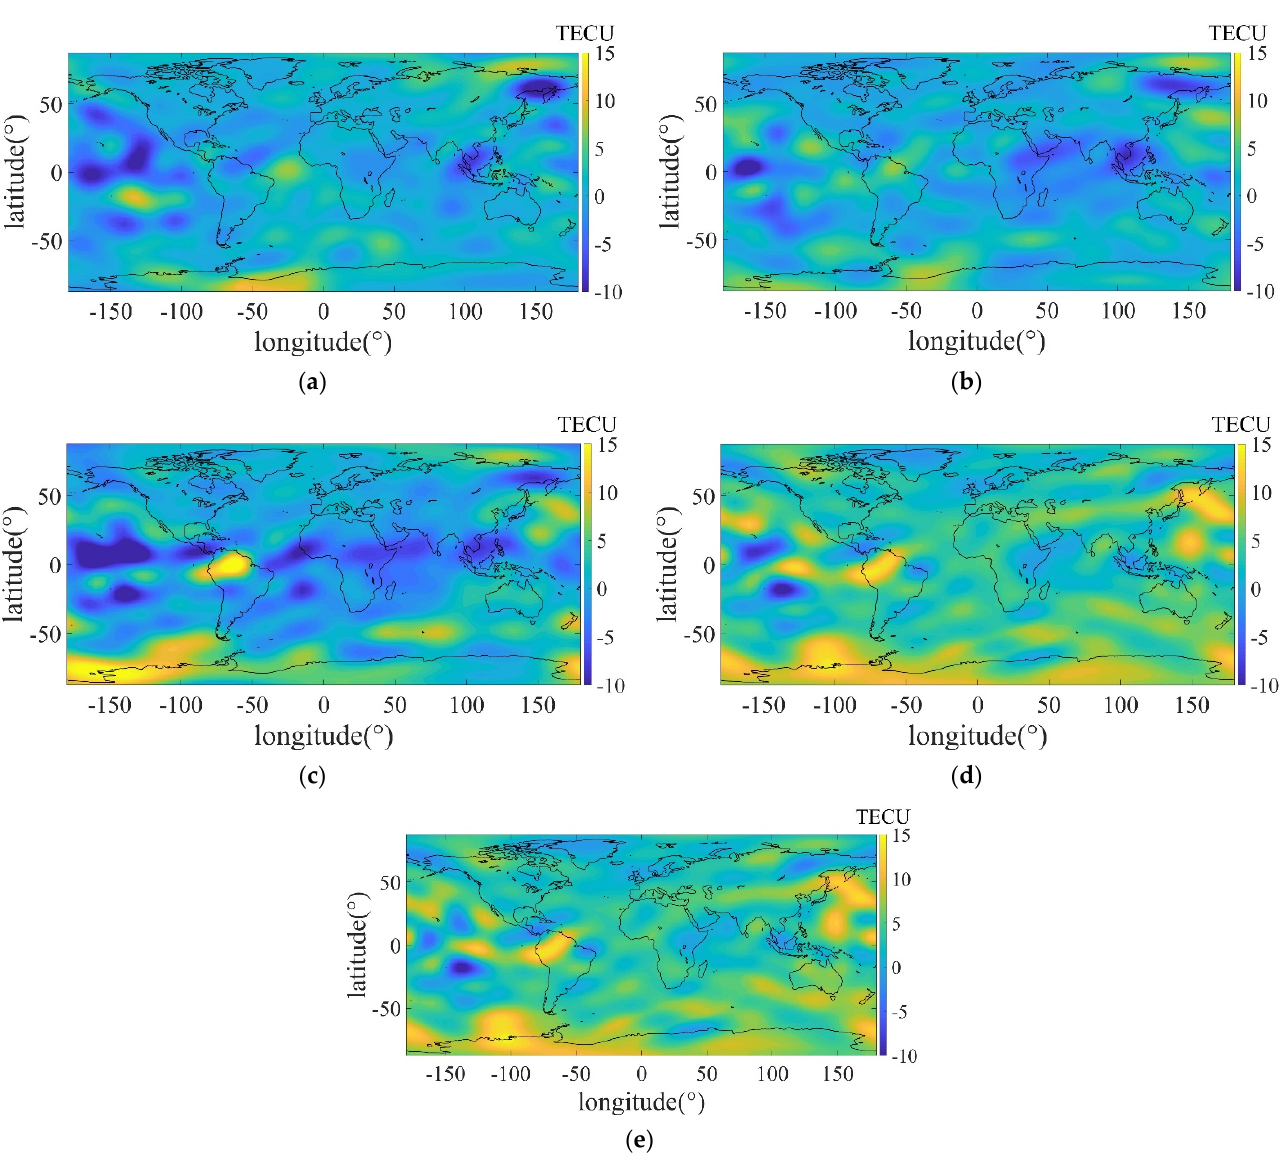
Figure 7. Biases between different results and CODE GIM at UT 0:00 DOY 308 in 2021: ( a ) GPS; ( b ) GLONASS; ( c ) Galileo; ( d ) BDS; ( e ) BDS (MEO + IGSO).